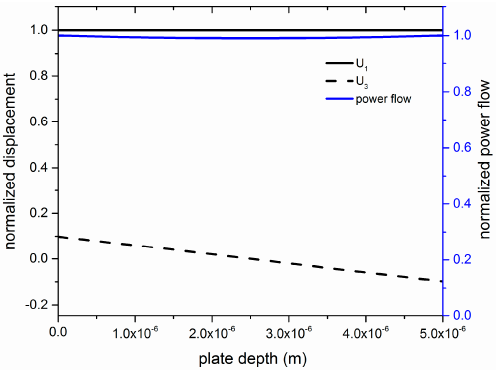
Figure 2. The U 1 , U 3 and power flow depth profile for an a-SiC plate with a thickness of 5 µm (h aSiC / λ = 0.1, λ = 50 µm). (h λ = 0.1, λ = 50 µ aSiC /